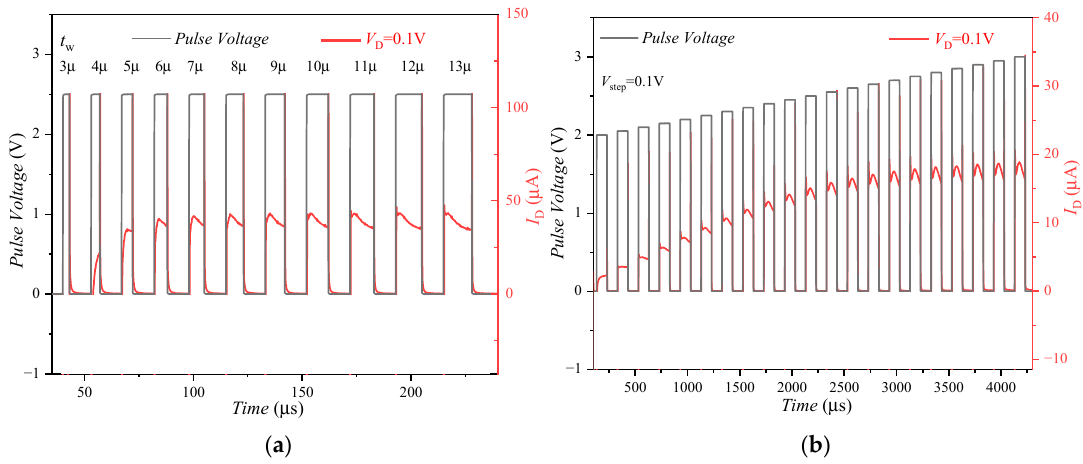
Figure 9. Effect of CT on ( a ) pulse width and ( b ) pulse amplitude modulation channel conductivity for FeFET. The gate of FeFET is applied with a pulse sequence with gradually increasing pulse width and pulse amplitude, and the drain current value is read out under a fixed drain voltage ( V D = 0.1 V). Similarly, when a pulse sequence with a continuously increasing pulse amplitude is applied to the gate of the FeFET, as shown in Figure 9b, the I D increases with the number of